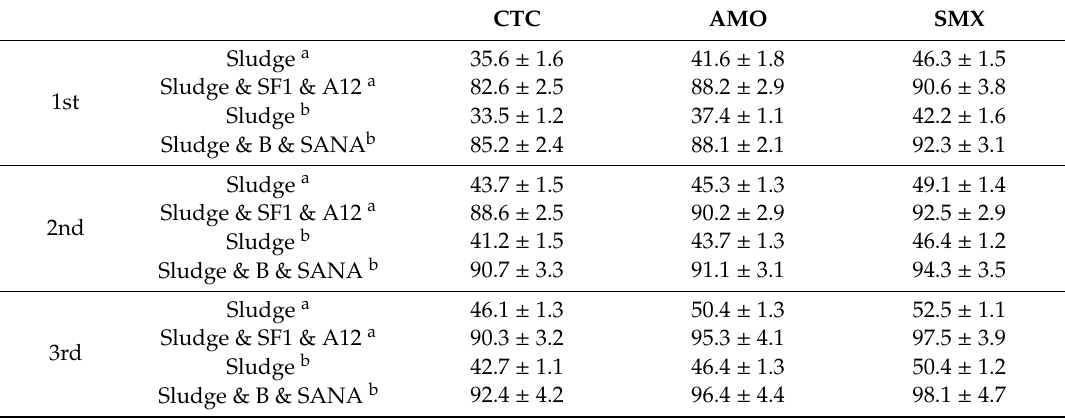
Table 2. The removal rates (%) after the first (1st), second (2nd), and third (3rd) additions of